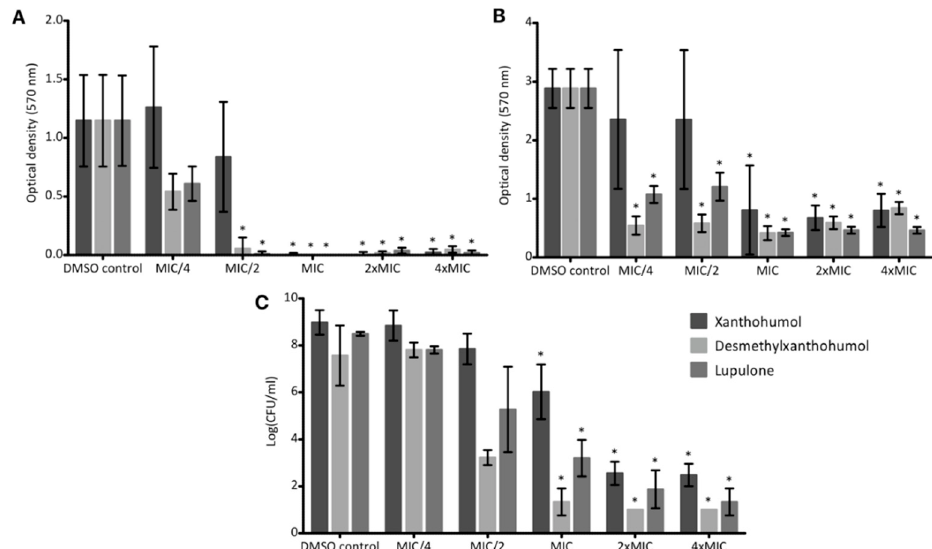
Figure 7. Effect of xanthohumol, desmethylxanthohumol and lupulone on the biofilm formation ( A ) of S. aureus T28.1 on artificial surface ( A ), on the biofilm destruction of S. aureus T28.1 on artificial surface ( B ) and on the biofilm formation of S. aureus T28.1 on bone substitute ( C ). According to Shapiro test, means tagged with * are significantly different from the control ( p = 0.05) using Kruskal Wallis and Dunn’s tests for ( A ) and for lupulone and desmethylxanthohumol for ( C ) or ANOVA and Tukey test for ( B ) and for xanthohumol for ( C ).